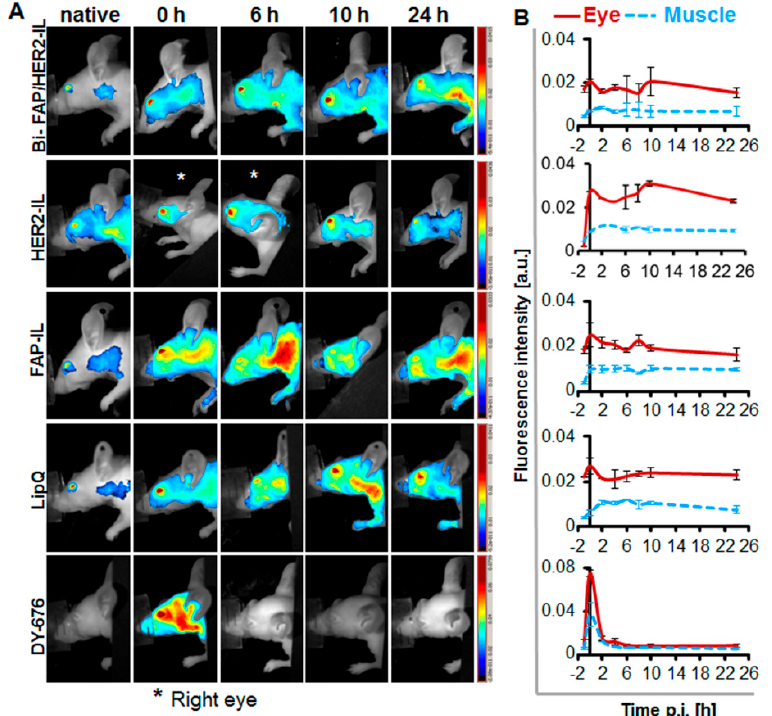
Figure 3. Fluorescence imaging of the eyes as a tool for monitoring the stability of fluorescence activatable liposomes in vivo during circulation. ( A ) NIRF images of the head region of the mice showing fluorescence of the eyes. ( B ) Semiquantitative levels of the fluorescence intensities of regions of interest (ROIs) placed in the eyes or background (back) of the mice. n = 2 ± SD.